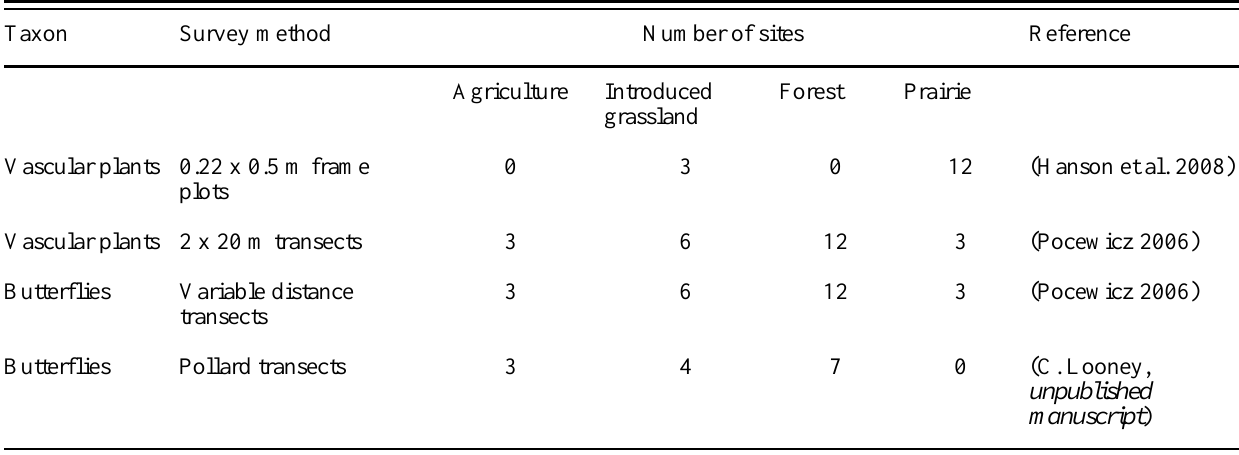
Table 3 . Biological data used to create species richness maps.